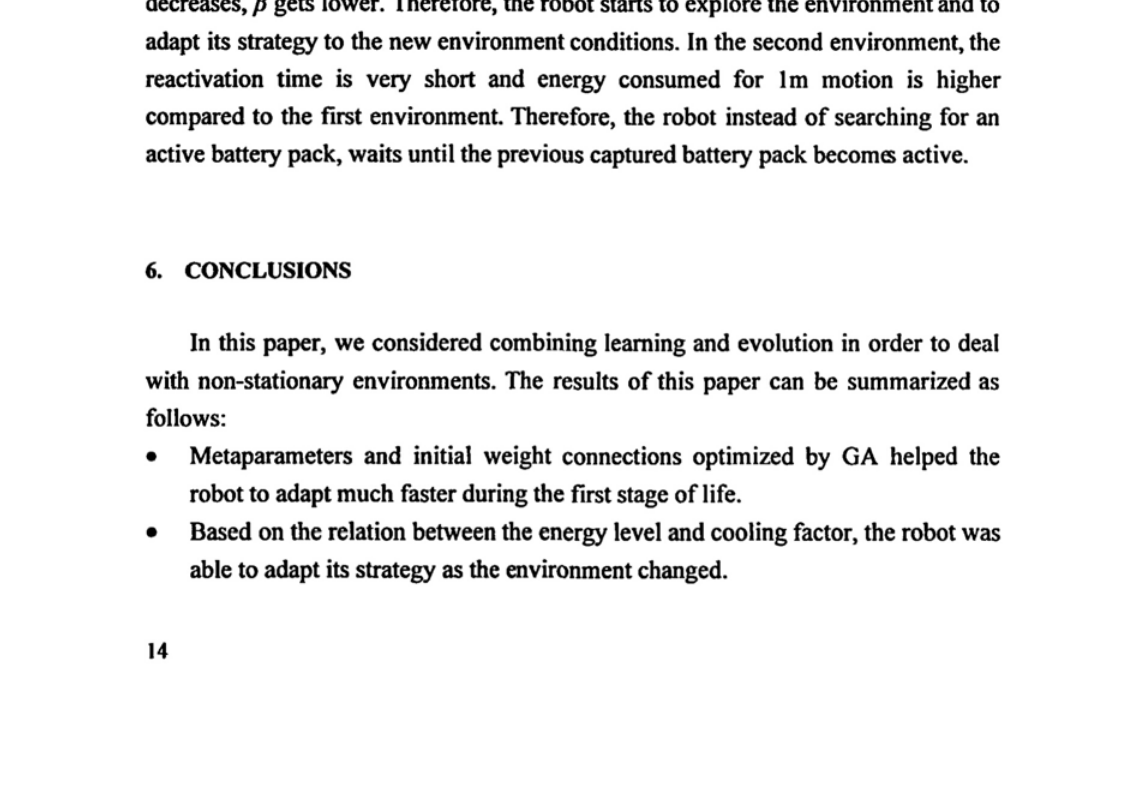
Fig. 6. Energy level and cooling factor during the robot